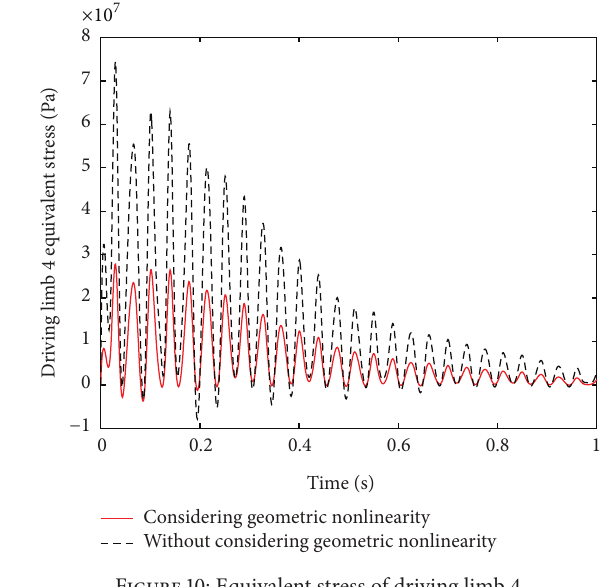
Figure 8: Equivalent stress of driving limb 2.